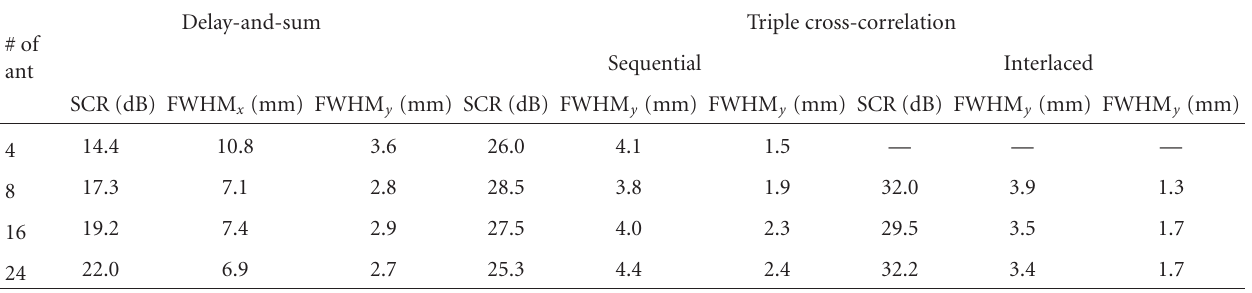
Table 2: SCR and FWHM from experiments with di ff erent number of